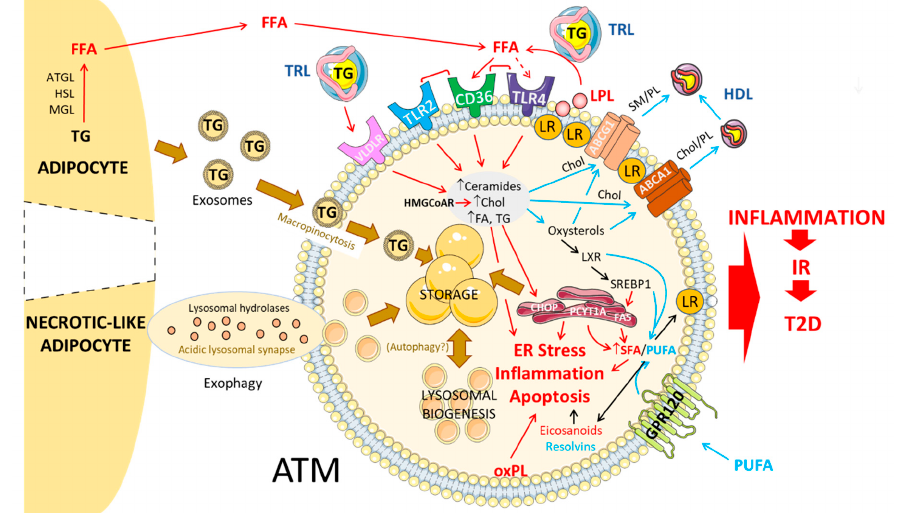
Figure 1. Lipid handling in adipose tissue macrophages in diet-induced obesity. In diet-induced obesity, adipose tissue macrophages are metabolically activated by free fatty acids (FFA) released by lipolysis of triglycerides from adipocytes or from triglyceride-rich lipoproteins by lipoprotein lipase, through Cd36 and toll-like receptors. Accumulation and storage of lipids in adipose tissue macrophages (ATMs) under the form of lipid droplets occur through the uptake of triglyceride-rich lipoproteins by specific receptors such as very low-density lipoprotein (VLDLR) or through the internalization of adipocyte-derived exosomes by macropinocytosis. In crown-like structures, necrotic-like adipocyte clearance by ATM in acidic lysosomal synapses through a mechanism of exophagy also contributes to foam cell formation. As a result, ATMs are characterized by an increased content of triglycerides, free cholesterol, ceramides and fatty acids, which can either be synthesized into other lipids (See Figure 2), be stored in lipid droplets or catabolized through the lysosomal pathway. The accumulation of free cholesterol and sphingolipids such as sphingomyelin into membrane lipid rafts promotes the recruitment of TLR4 at the cell surface and contributes to the activation of inflammatory signaling pathways. ABCA1 and ABCG1 transporters promote the efflux of lipids from ATM to high-density lipoproteins allowing the reduction in lipid raft formation, thus ensuring an optimal lipoprotein lipase activity which participates in foam-like cell formation. Fatty acid synthesis, elongation and desaturation are under the control of liver X receptor (LXR) and sterol regulatory element-binding protein (SREBP1) thus exerting an important role in the relative cellular content of saturated and polyunsaturated fatty acids. Increased cellular levels of free cholesterol and saturated fatty acids trigger endoplasmic reticulum stress, inflammation and apoptosis, which can be alleviated by an enrichment in polyunsaturated fatty acids through mechanisms dependent or independent of the GPR120 receptor. Production of eicosanoids and resolvins from ω -6 and ω -3 polyunsaturated fatty acids, respectively, induces or represses inflammation in ATM. Increased turnover of phosphatidylcholine as well as oxidation of phospholipids also participate in the inflammatory status of ATM. As a whole, the rewiring of the lipid metabolism in ATM promotes adipose tissue inflammation and contributes to the establishment of insulin resistance and type 2 diabetes. ABCA1, ATP-binding cassette A1; ABCG1, ATP-binding cassette G1; ATGL, Adipose triglyceride lipase; Chol, cholesterol; CHOP, CCAAT-enhancer-binding protein homologous protein; FAS, fatty acid synthase; FFA, free fatty acids; GPR120, G protein-coupled receptor 120; HMGCoAR, 3-hydroxy-3-methyl-glutaryl-coenzyme A reductase; HSL, hormone-sensitive